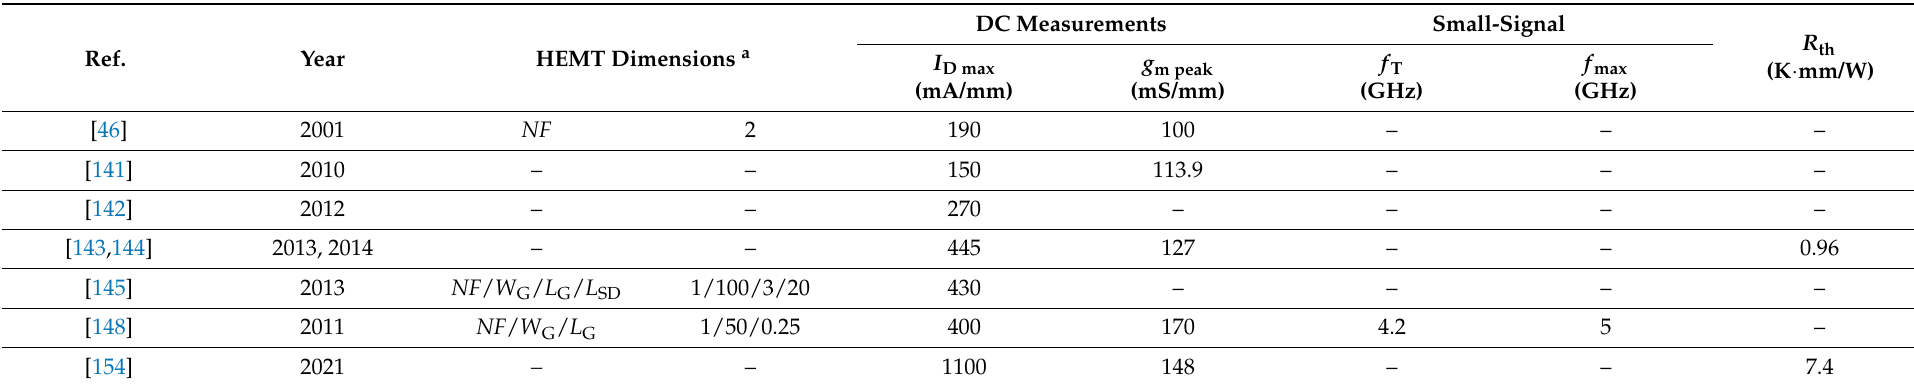
Table A4. Relevant electrical parameters of HEMTs featuring capping diamond.